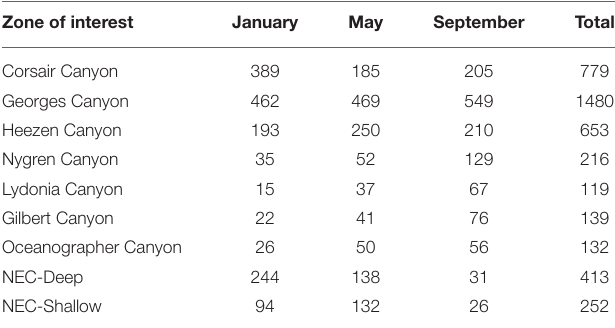
TABLE 4 | Number of tracks originating from each of the 9 zones of interest and ending at 15 endpoints offshore of Corsair Canyon (northwest Atlantic). Zone of